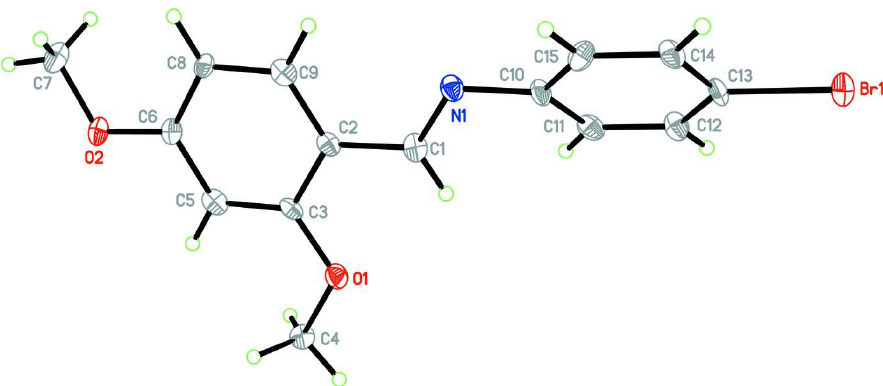
Figure 1 The structure of (I) with displacement ellipsoids for the non-hydrogen atoms drawn at the 50% probability level.